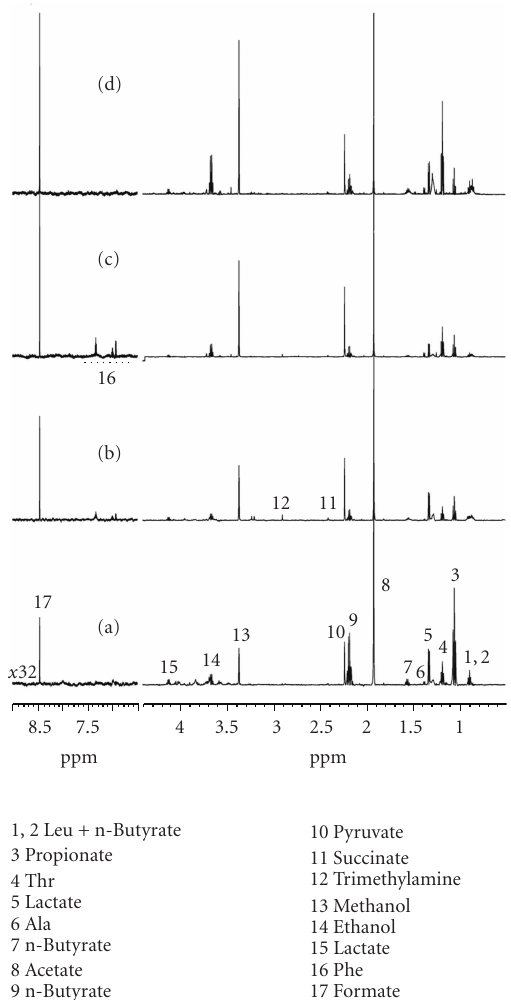
Figure 3: Resonance assignments of representative 1 H-NMR spectra of EBC samples. The spectra of healthy (a), asthmatic (b), steroid-treated asthmatic (c), and COPD (d) patients are depicted. Peaks are labeled with progressive numbers, and assignments are listed